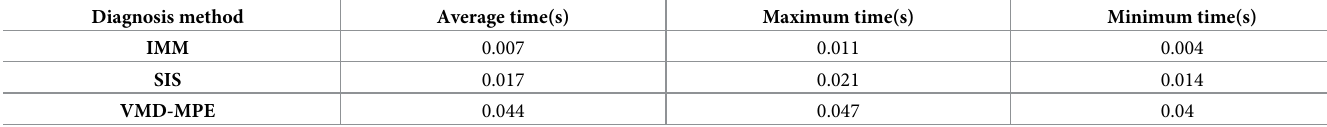
Table 11. Comparison of fault diagnosis